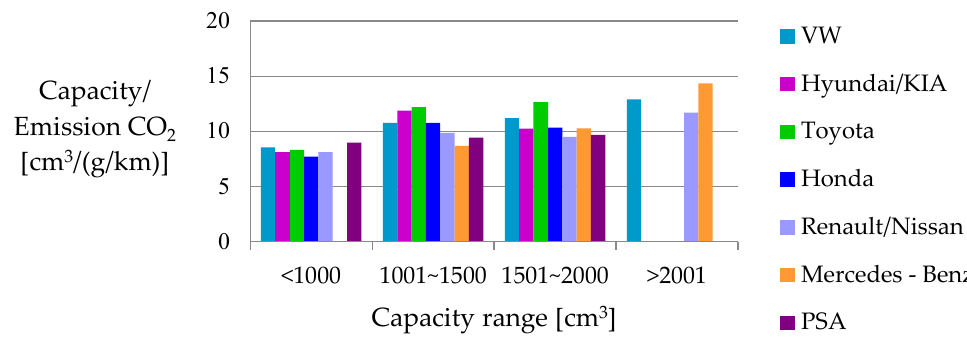
Figure 7. The ratio of displacement to combustion in the individual engine capacity compartments; European and Asian car brands. Source: Developed own.